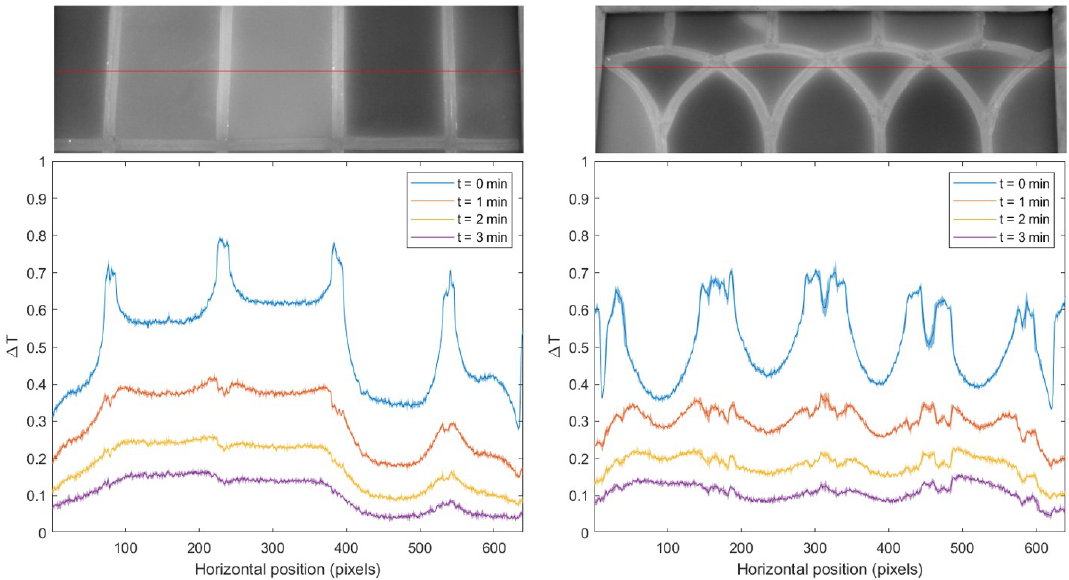
Figure 5. Top row: the red lines in the reflection mode thermograms are line scans, indicating the position of the pixels for which the values are displayed in the graph. Bottom row: the graphs show the temperature difference at different times of cooling-down averaged over 3 pixels. Temperature differences are normalized over the entire data cube. The lead cames heavily influence the temperature behavior of the surrounding glass. The larger glass panes ( left ) have an area that remains unaffected but this is not the case for the smaller glass panes ( right